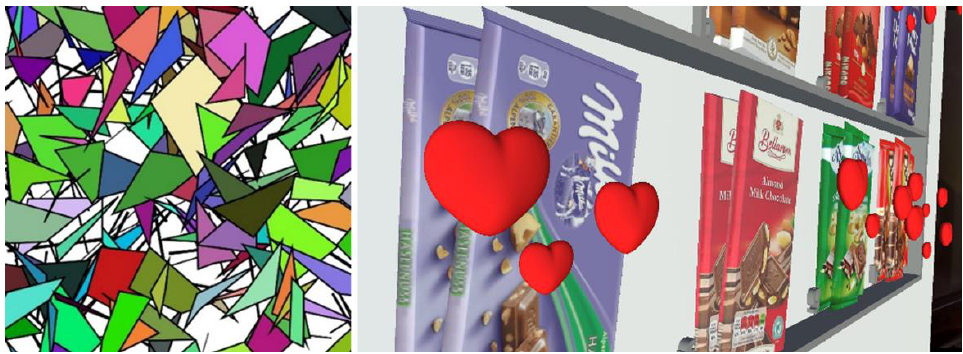
Figure 2. Marker ( left ) a nd the layout of an interactive digital visual display in AR application ( right